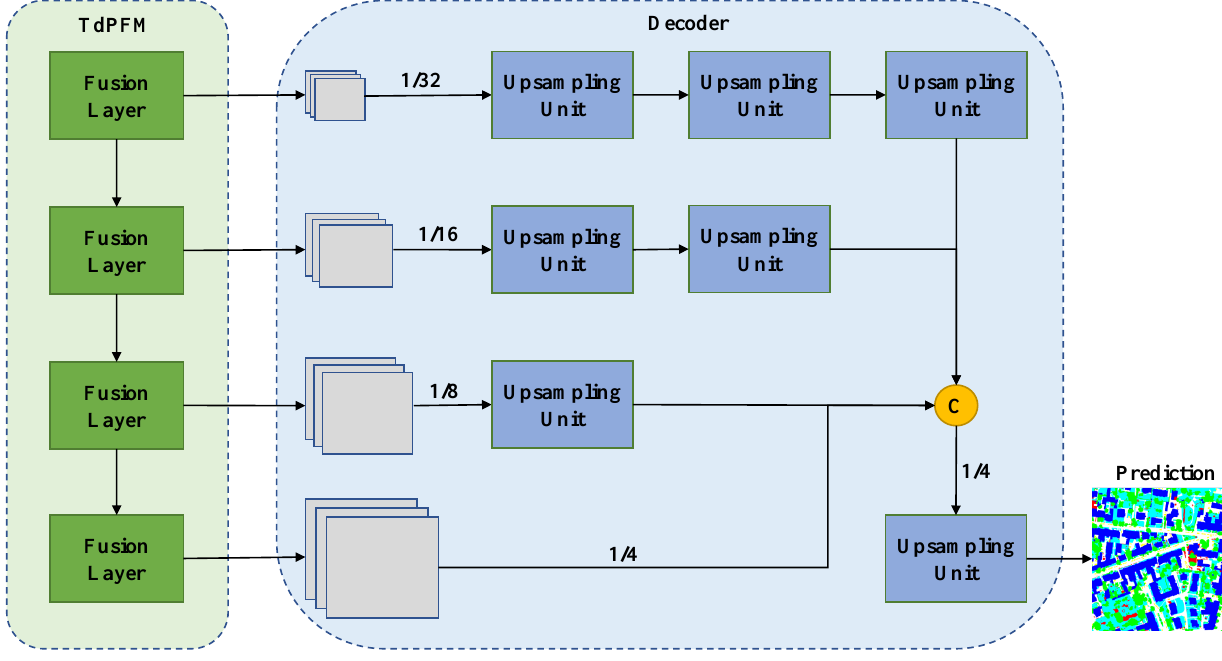
Figure 6. The overall structure of TdPFNet (excluding extractor). It mainly includes two modules: Multi-source feature pyramid fusion module and lightweight decoder. The first module contains four fusion layers with different scales. The second module contains some upsampling units (where C represents concatenation operation). Multi-scale features from TdPFM are reconstructed to the images with the original resolution through multiple upsampling